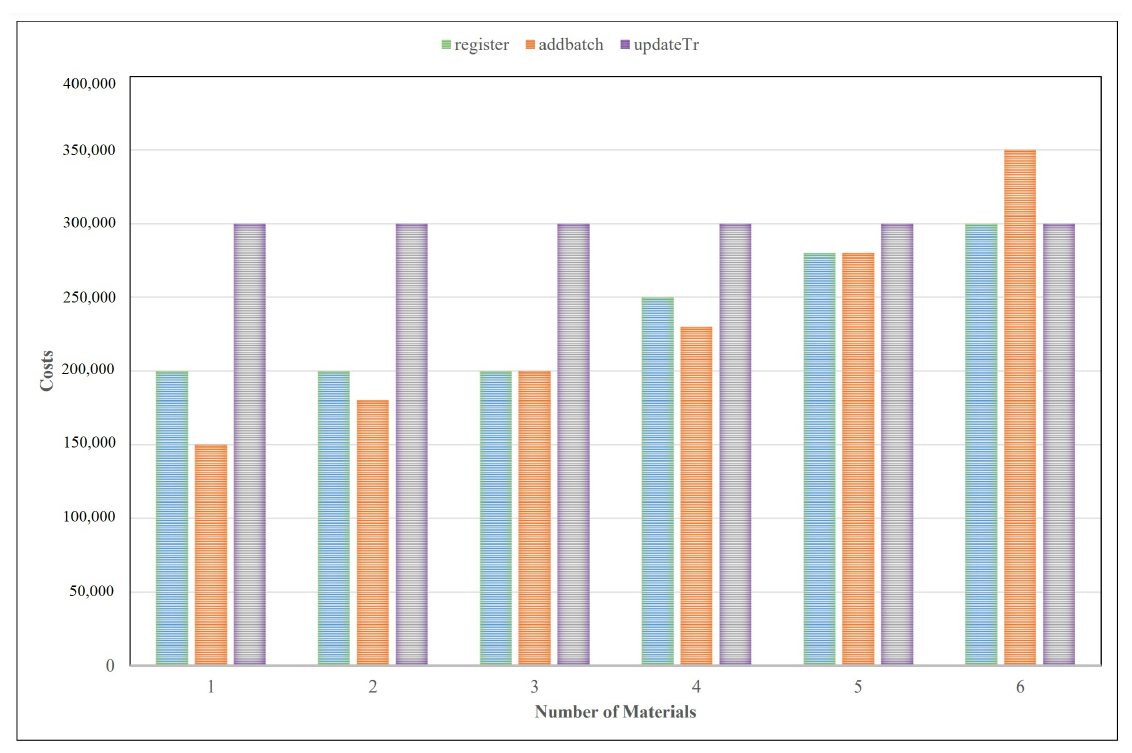
Figure 7. Smart contract operation costs.